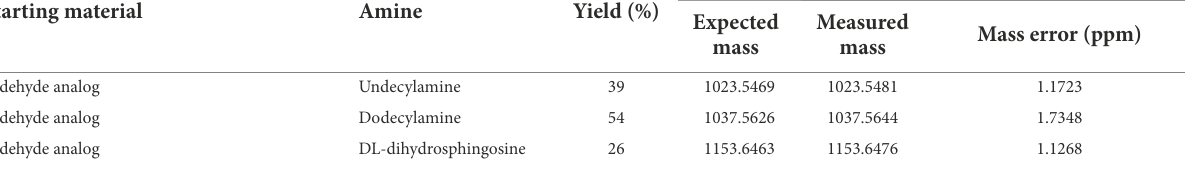
TABLE 2 Summary of